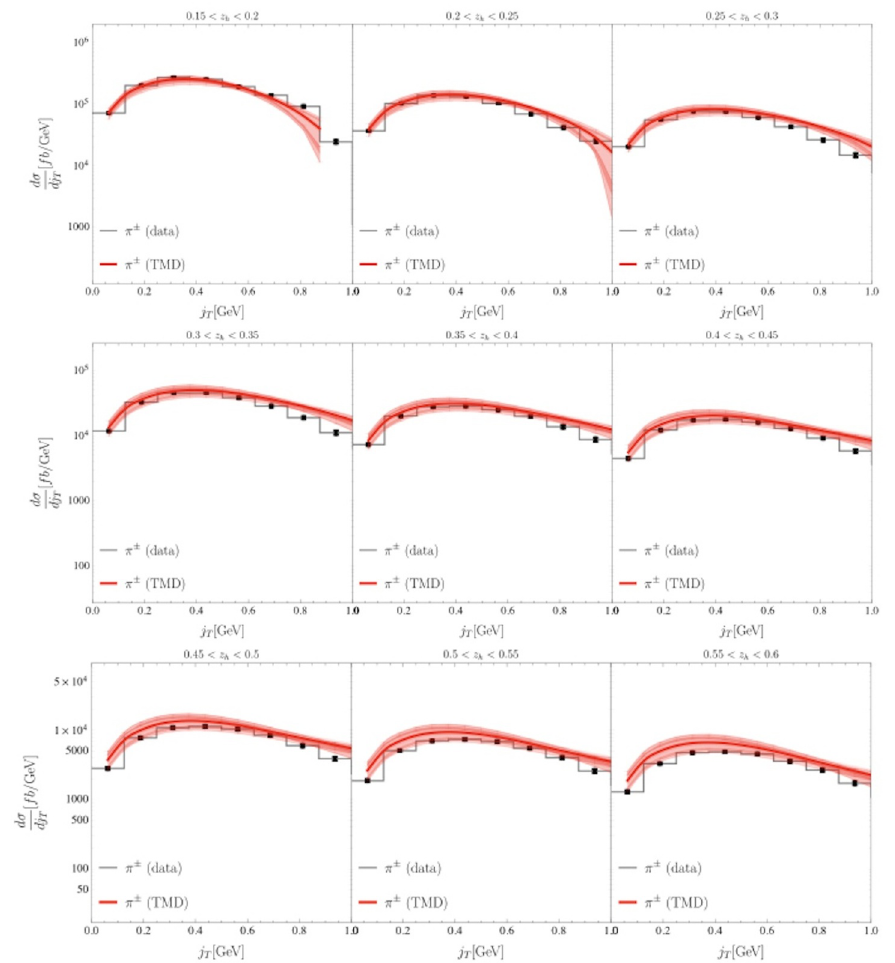
Figure 3 . Differential cross sections for the charged pion as a function of j T and different z h bins with ∆ z h = 0 . 05 interval in the region 0 . 15 < z h < 0 . 6 . In each plot, TMD resummation is applied and data points (black dots and histogram with error bars) from Belle collaboration [48] are shown for comparison. The red bands indicate theoretical uncertainties from the hard scale and FF variations as illustrated in the